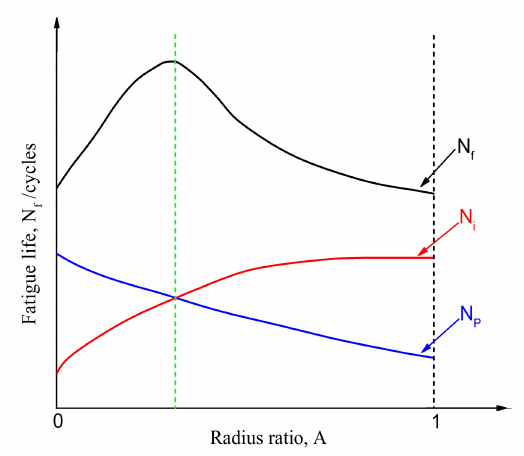
Figure 7. Relationship model between N f and A